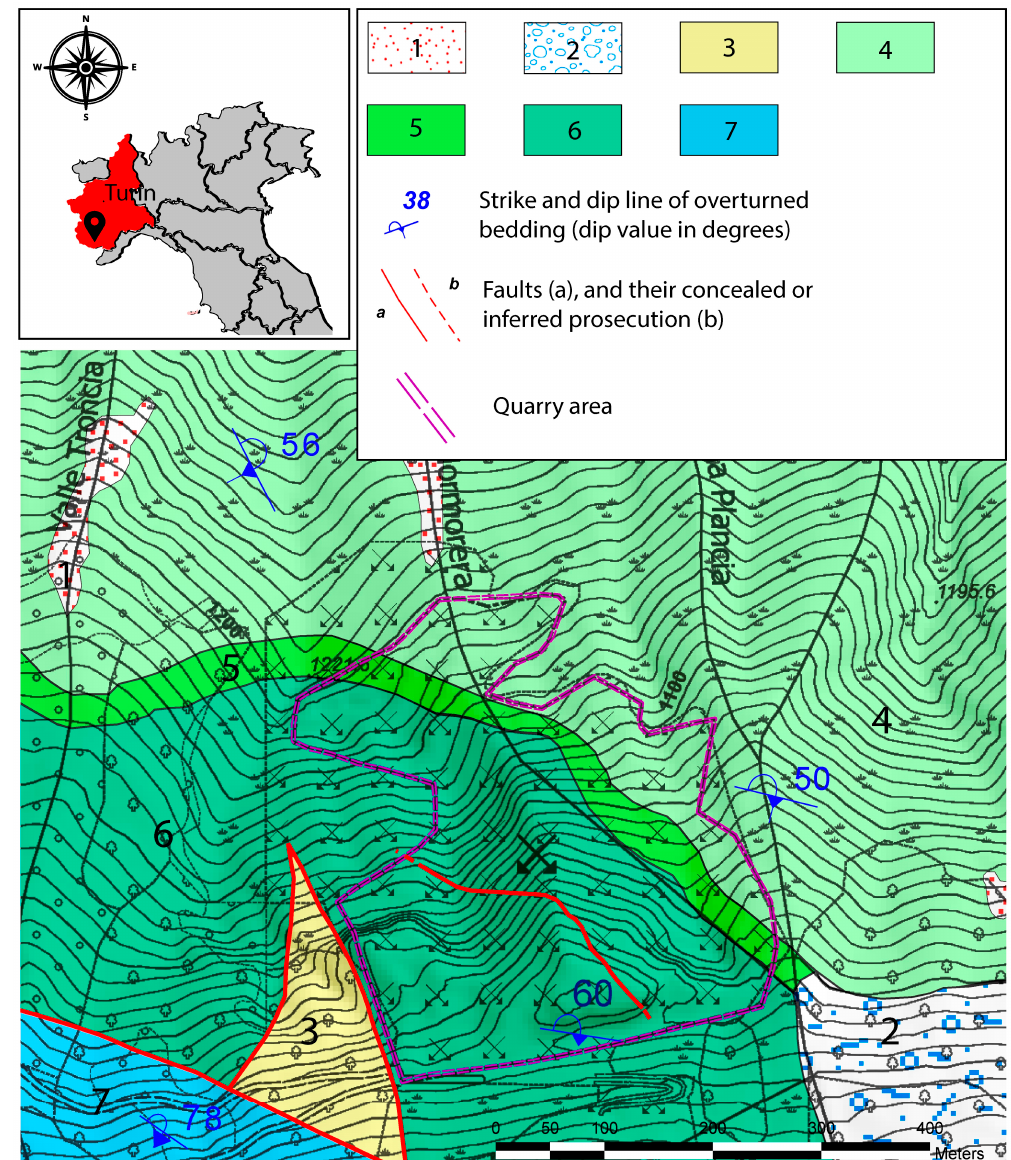
Figure 2. Location and geological map of the test site. Legend: 1—Slope and talus debris. 2—Undifferentiated glacial